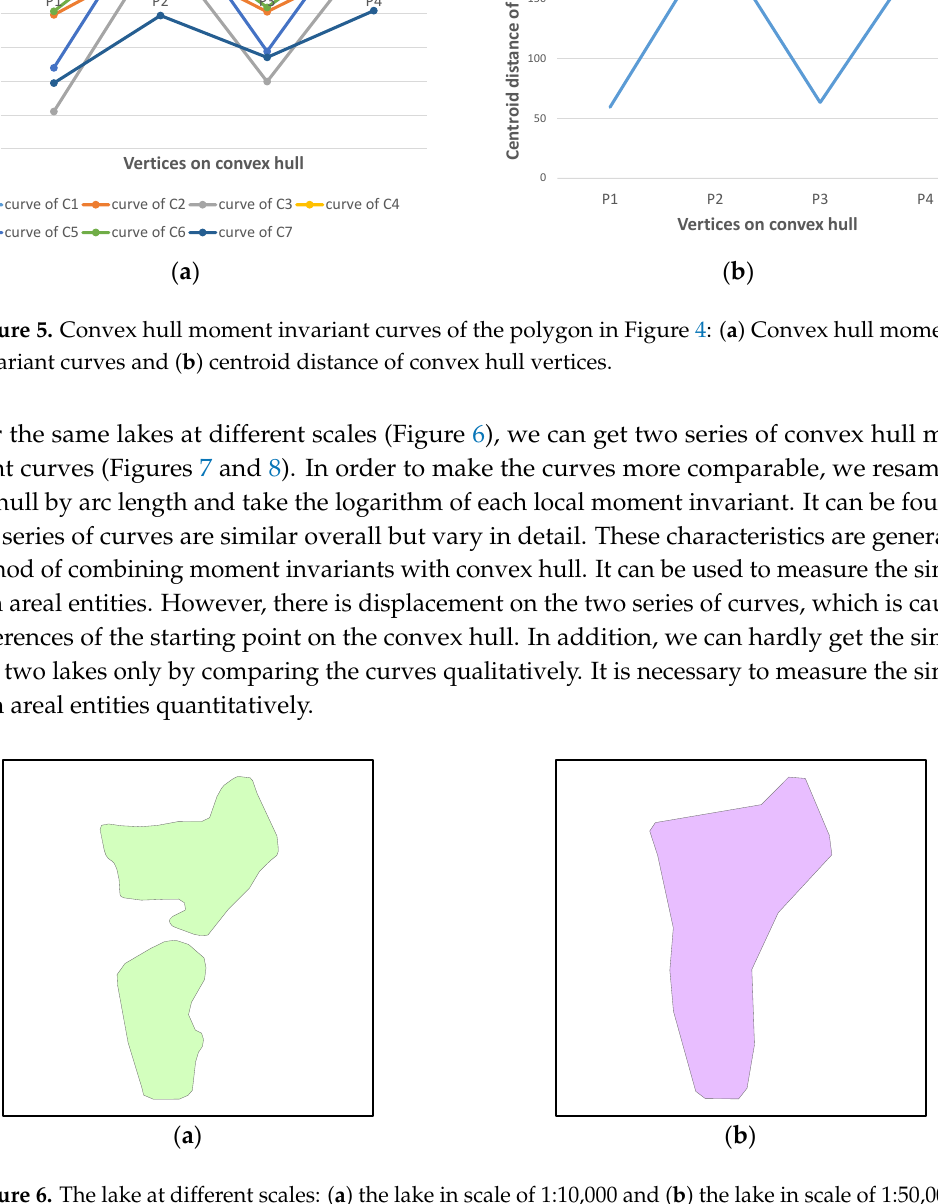
Figure 7. Convex hull moment invariant curves of the lake in scale of 1:10,000. Figure 8. Convex hull moment invariant curves of the lake in scale of 1:50,000.